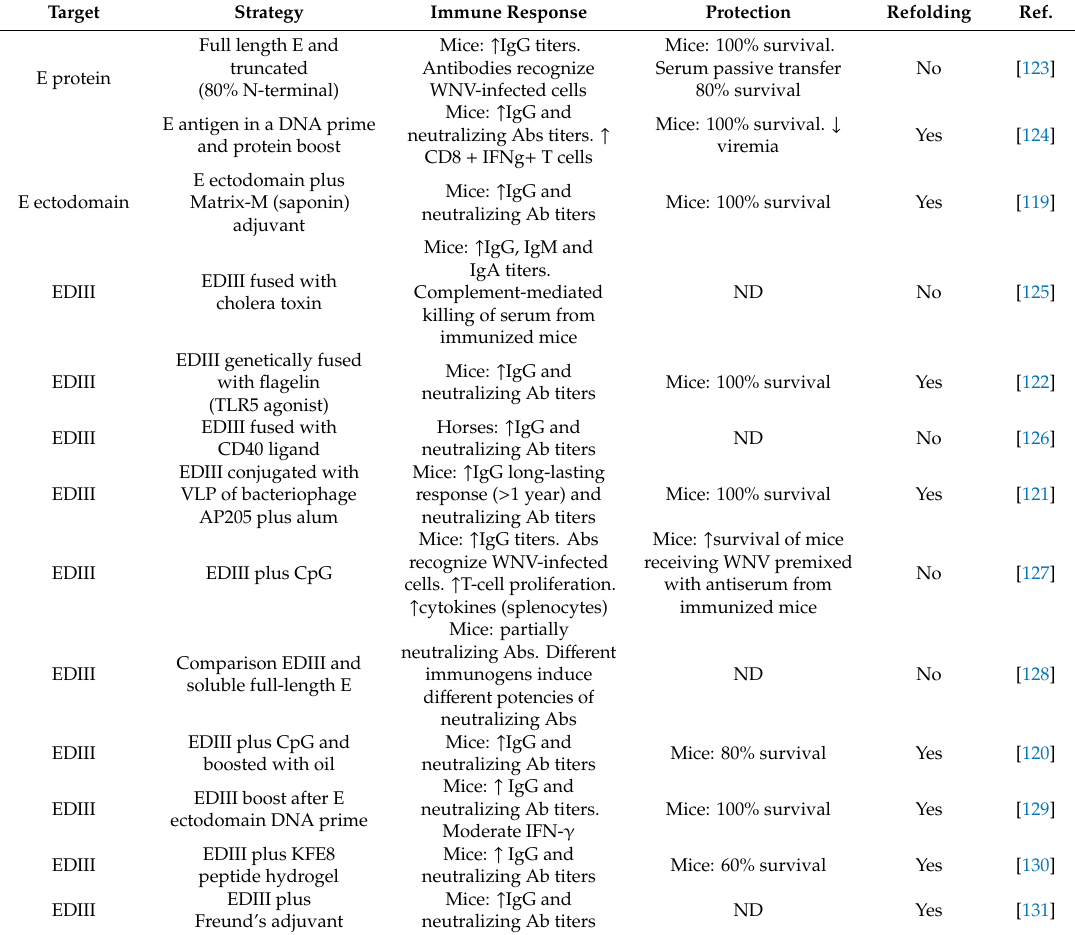
Table 3. Strategies for WNV subunit vaccines in preclinical